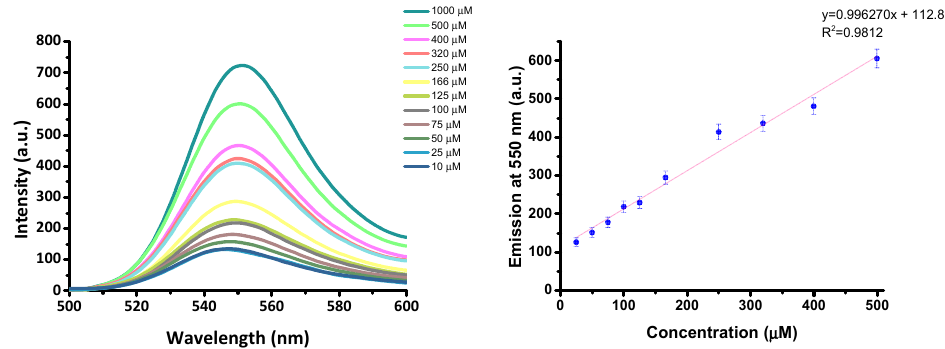
Figure 6. ( left ) Fluorescence titration of S1 with Spm. ( right ) Calibration curve: emission at λ em = 550 nm ( λ ex = 525 nm).